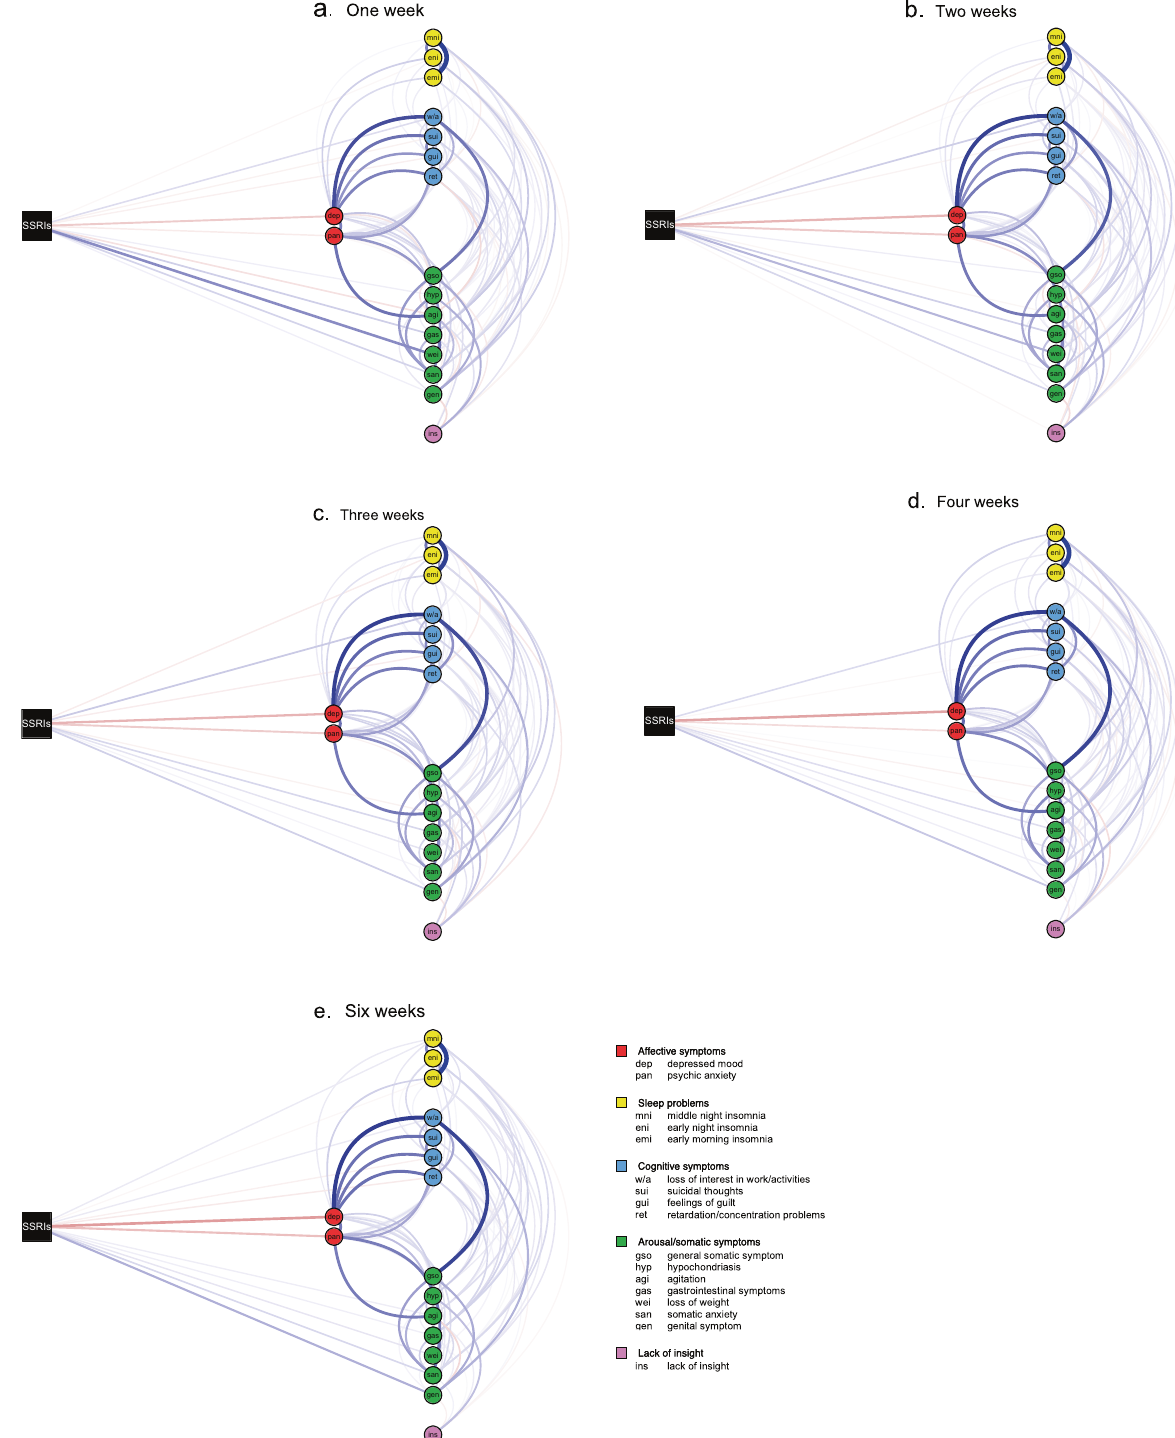
Fig. 1 Direct and indirect effects of SSRIs on 17 individual depression symptoms during six weeks of treatment. a Effects after 1 week of treatment. b Effects after 2 weeks of treatment. c Effects after 3 weeks of treatment. d Effects after 4 weeks of treatment. e Effects after 5 weeks of treatment. Treatment (SSRIs over placebo) is represented by a square and individual symptoms by circles. Red edges between SSRIs and symptoms indicate bene fi cial treatment effects (i.e., lower symptom scores for the SSRI condition relative to placebo), whereas blue edges indicate detrimental treatment effects (i.e., higher symptom scores for the SSRI condition relative to placebo). Red edges between symptoms indicate negative associations, whereas blue edges indicate positive associations. Thicker edges represent stronger